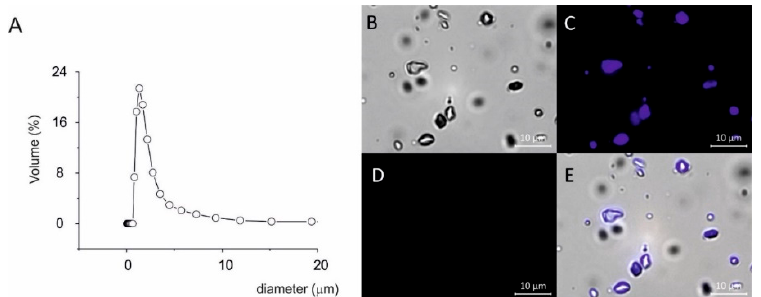
Figure 3. Properties of pure micronized resveratrol. ( A ) Granulometric analysis of microcrystalline resveratrol. ( B – E ) Image of crystalline resveratrol powder dispersed in glycerol under different excitation sources. ( B ) Bright-field; ( C ) DAPI fluorescence filter; ( D ) Rhodamine fluorescence filter. ( E ) Merging of the Bright-field, DAPI and Rhodamine images.